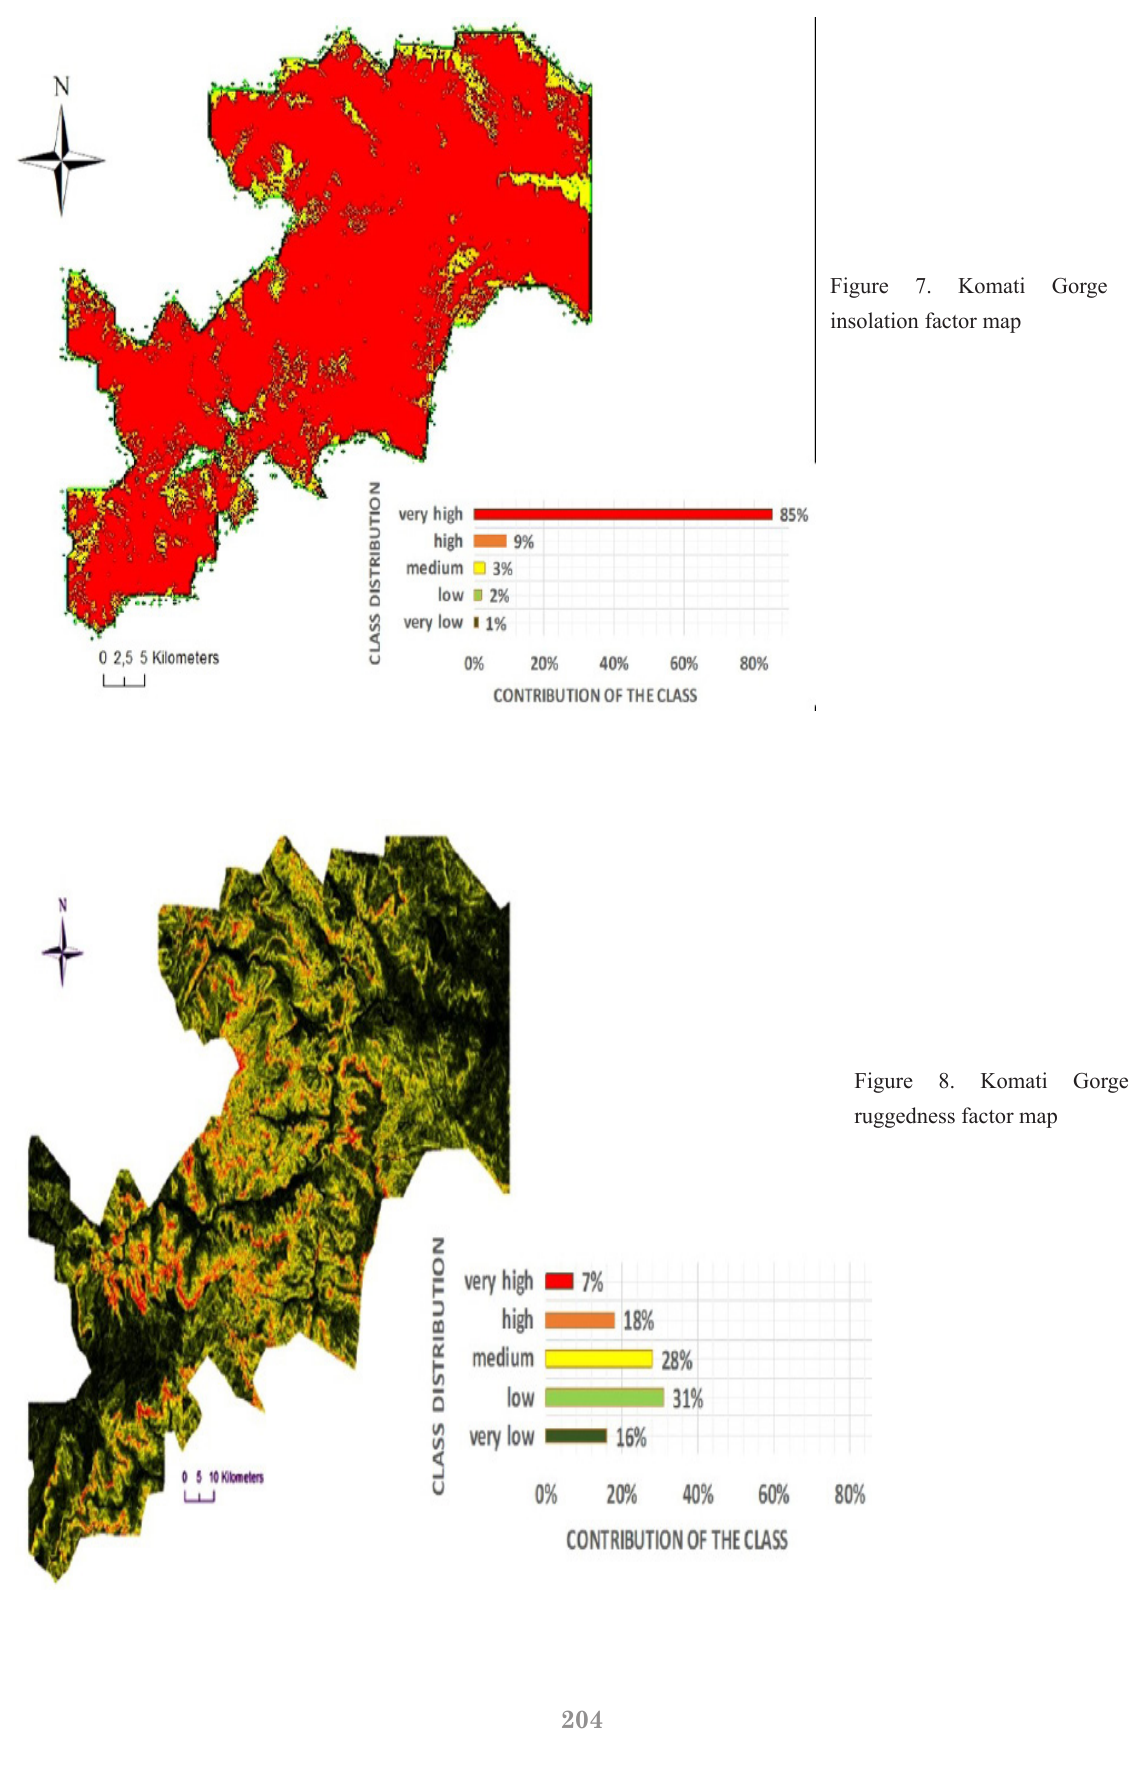
7. Komati Gorge insolation factor map